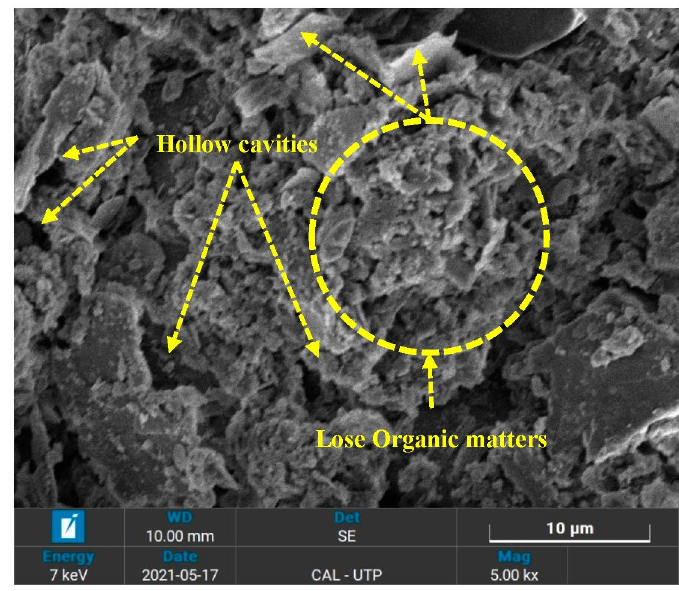
Figure 2. SEM image of untreated peat.